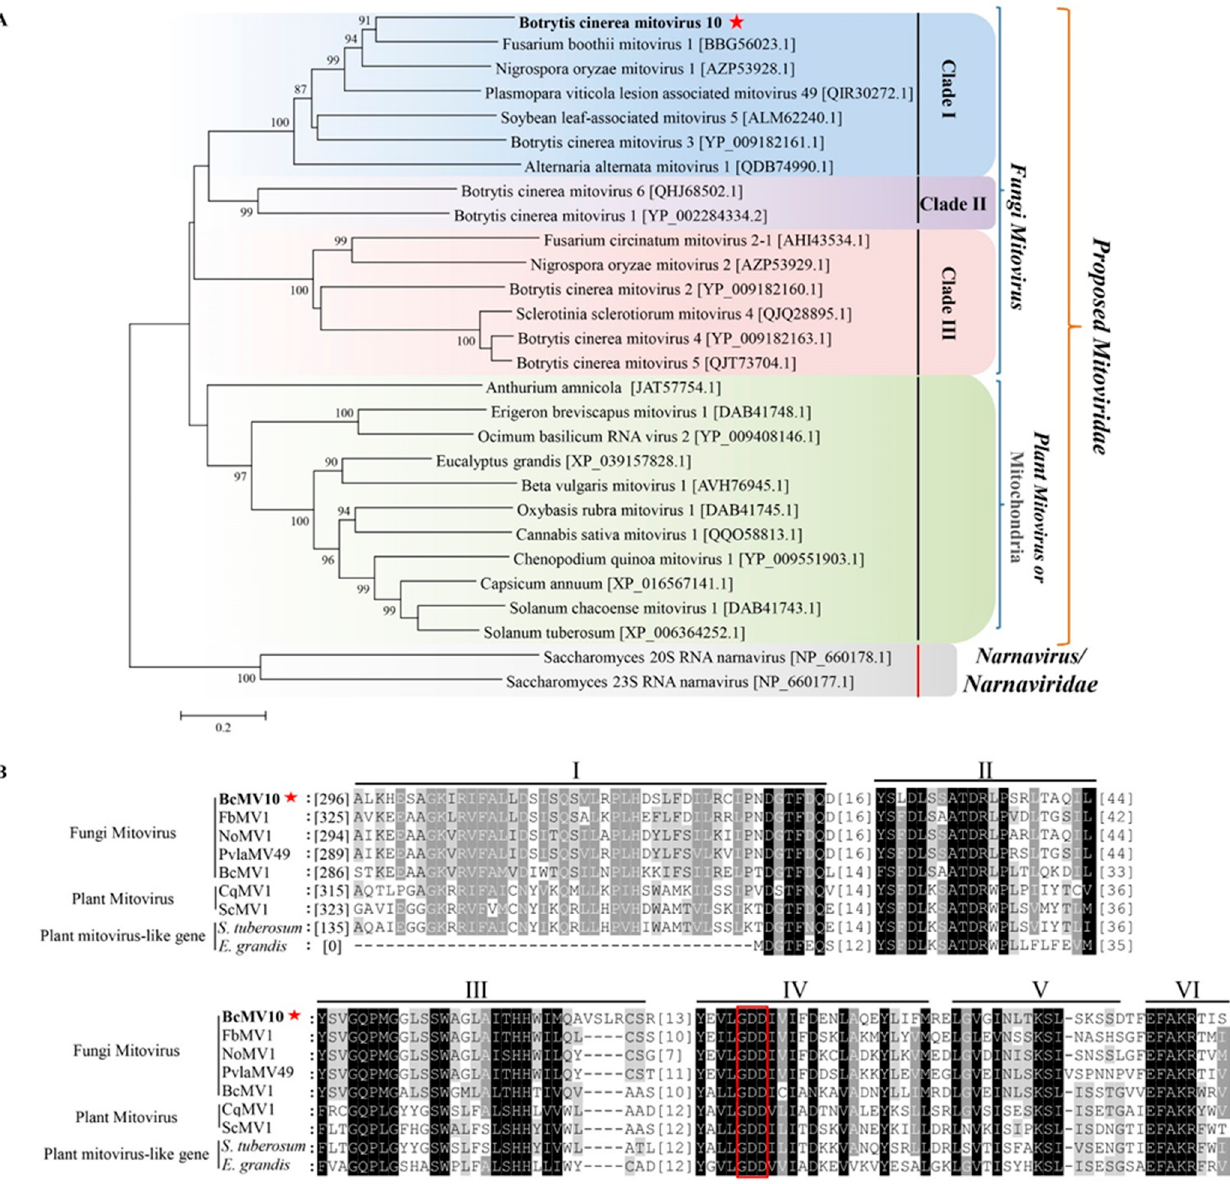
Figure 4. Neighbour-joining phylogenetic tree analysis: ( A ) multiple-sequence alignment comparisons of RdRp aa sequences of; ( B ) BcMV10, selected fungi mitoviruses, plant mitoviruses, and plant mitochondria belonging to the proposed Mitoviridae family. Mycoviral names, followed by GenBank accession numbers, are shown. Bold letters with red pentagrams represent the target virus BcMV10 characterised in this study. The conserved RdRp motifs of BcMV10 are indicated using Roman numerals from I to VI. The red box indicated the conserved domain GDD (motif